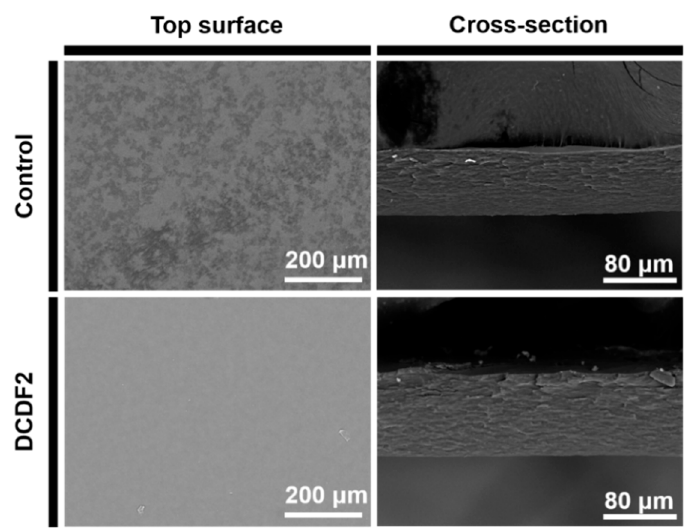
Figure 2. Scanning electron microscope (SEM) images of the control film and the DCDF film (DCDF2) in top-surface and cross-sectional views.